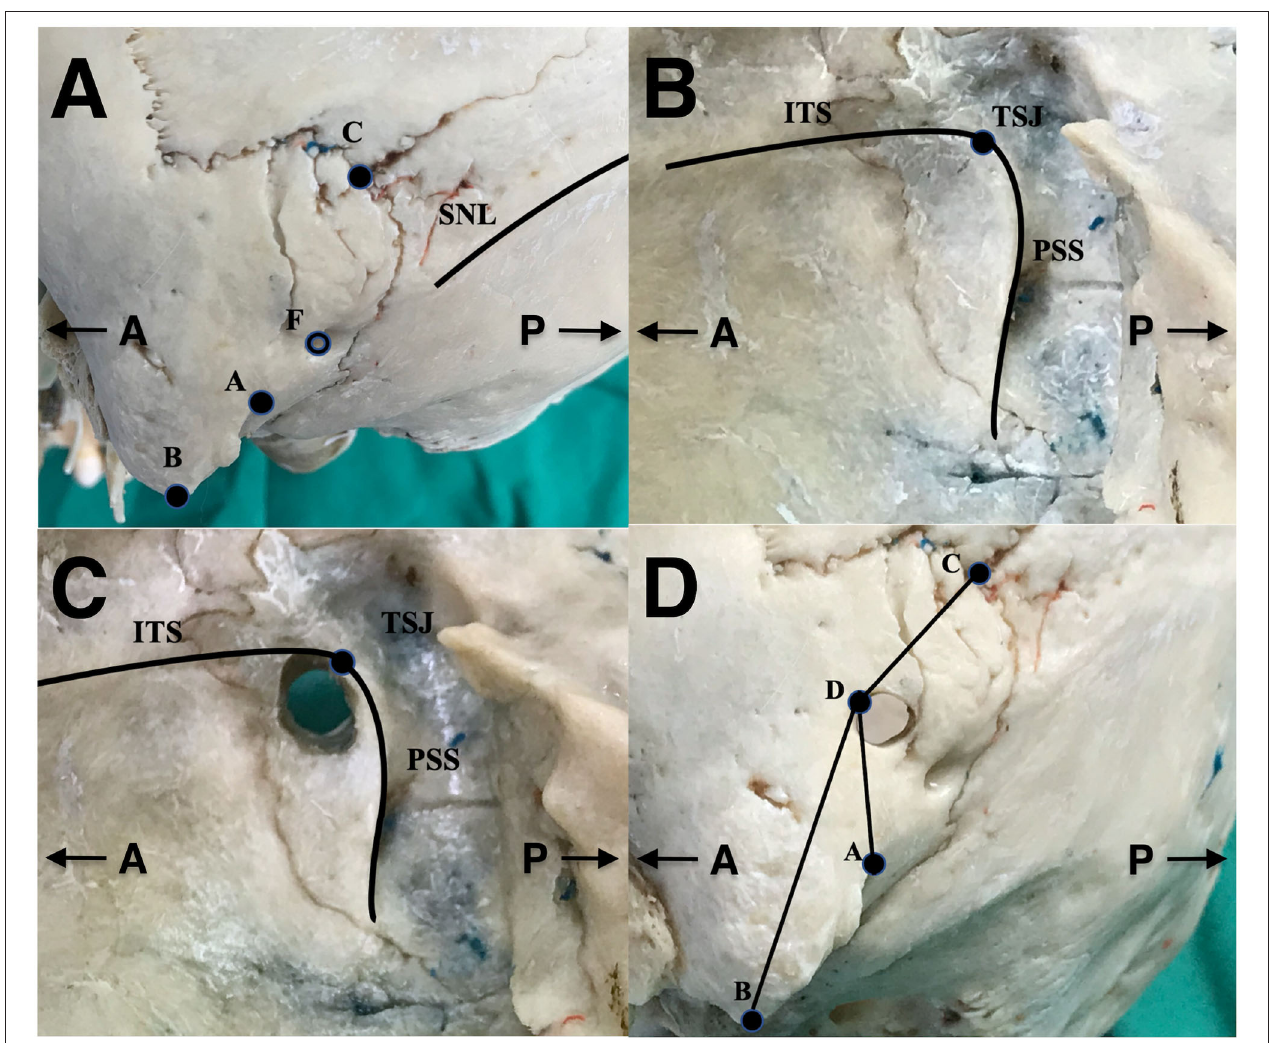
FIGURE 1 | The method used to locate the keypoint in dry skull. (A) Identification of extracranial anatomical landmarks on the external surface of the skull, (B) identification of the junction between the inferior margin of the transverse sinus and the posterior margin of the sigmoid sinus on the inner surface of the skull (TSJ), (C) burr hole from the interior to exterior surface on the basis of TSJ, and (D) measuring the length between anatomical landmarks on the external surface of the skull. A, the top point of the digastric groove; B, mastoidale; C, asterion; D, keypoint; F, mastoid foramen; TSJ, the inferior margin of the transverse sinus–posterior margin of the sigmoid sinus junction; SNL, superior nuchal line; ITS, the inferior margin of the transverse sinus; PSS, the posterior margin of the sigmoid